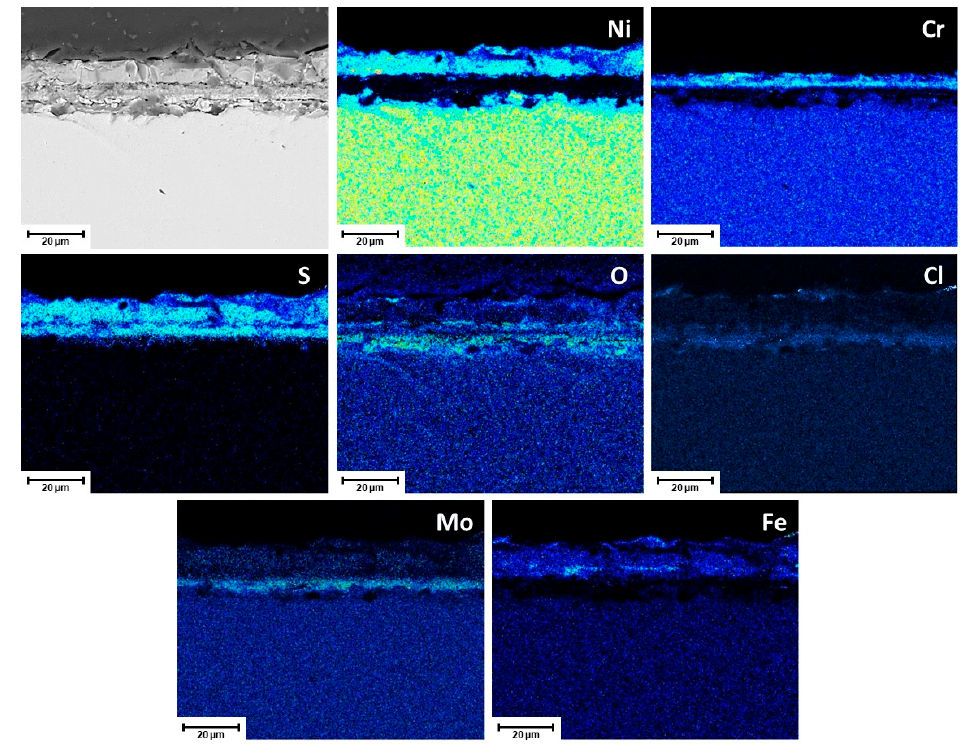
Figure 4. N10276 after 240 h at 480 °C. SEM and EDX element mapping of the cross section.